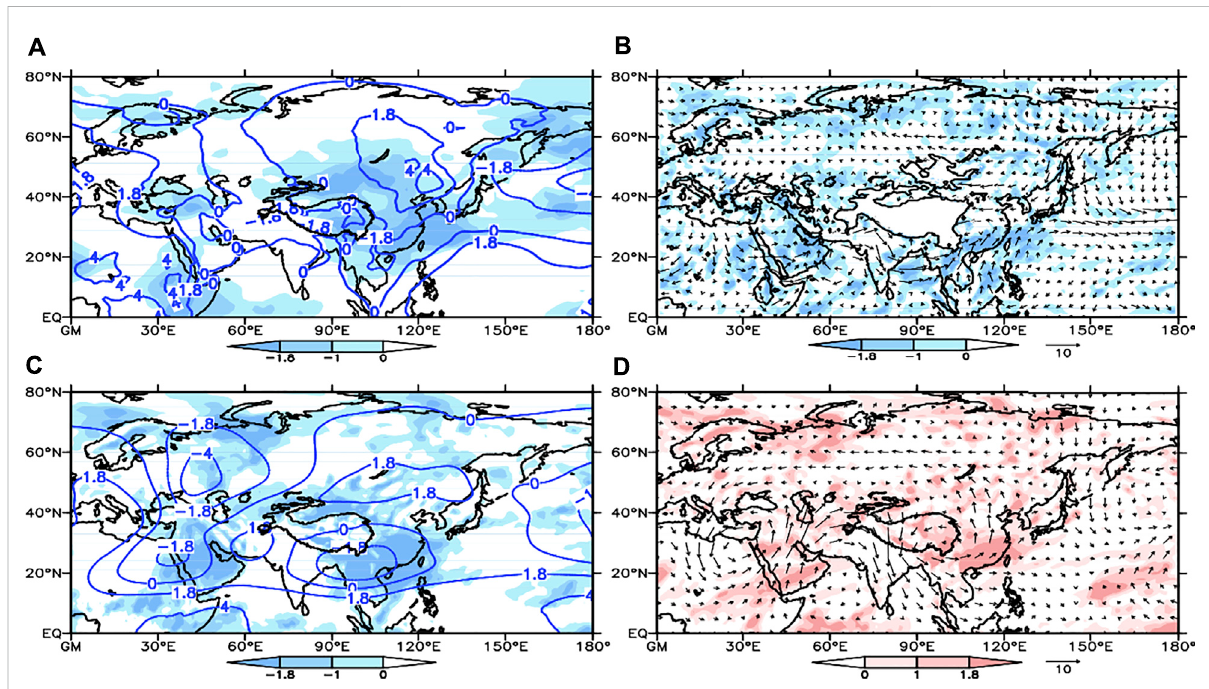
FIGURE 7 The t -test results of the difference of (A) sea level pressure (unit: hPa; contours) and OLR (unit: W/m 2 ; shadows), (B) wind (unit: m s − 1 ; vectors) and water vapor fl ux divergence (unit: 10 – 6 g · s-1 · cm-2 · hPa-1; shadows) at 850 hPa, (C) geopotential height (unit: gpm; contours) and vertical velocity (unit: hPa/s; shadows) at 500 hPa, and (D) wind (unit: m s − 1 ; vectors) and divergence (unit: s − 1 ; shadows) at 200 hPa between the stronger and weaker winter FAT years. The values larger than 1.8 have passed the signi fi cance test at the 0.1 signi fi cance